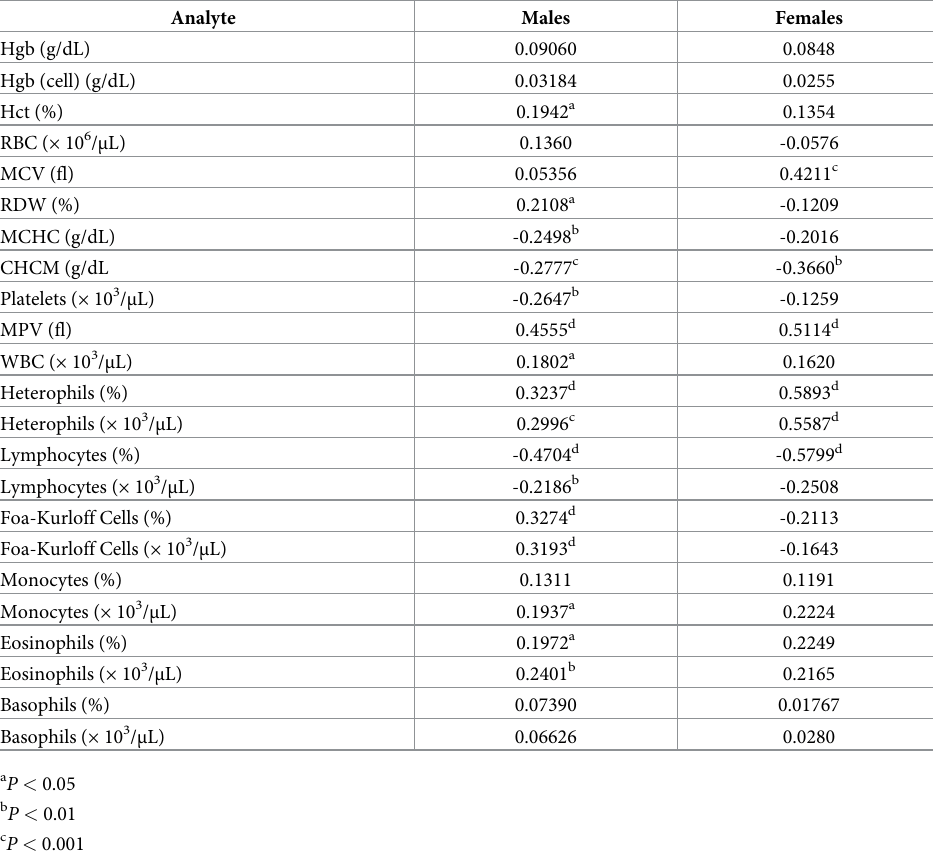
Table 2. Spearman correlation (r) of hematology parameters with age in 145 male and 67 female Dunkin Hartley guinea pigs. Analyte Males